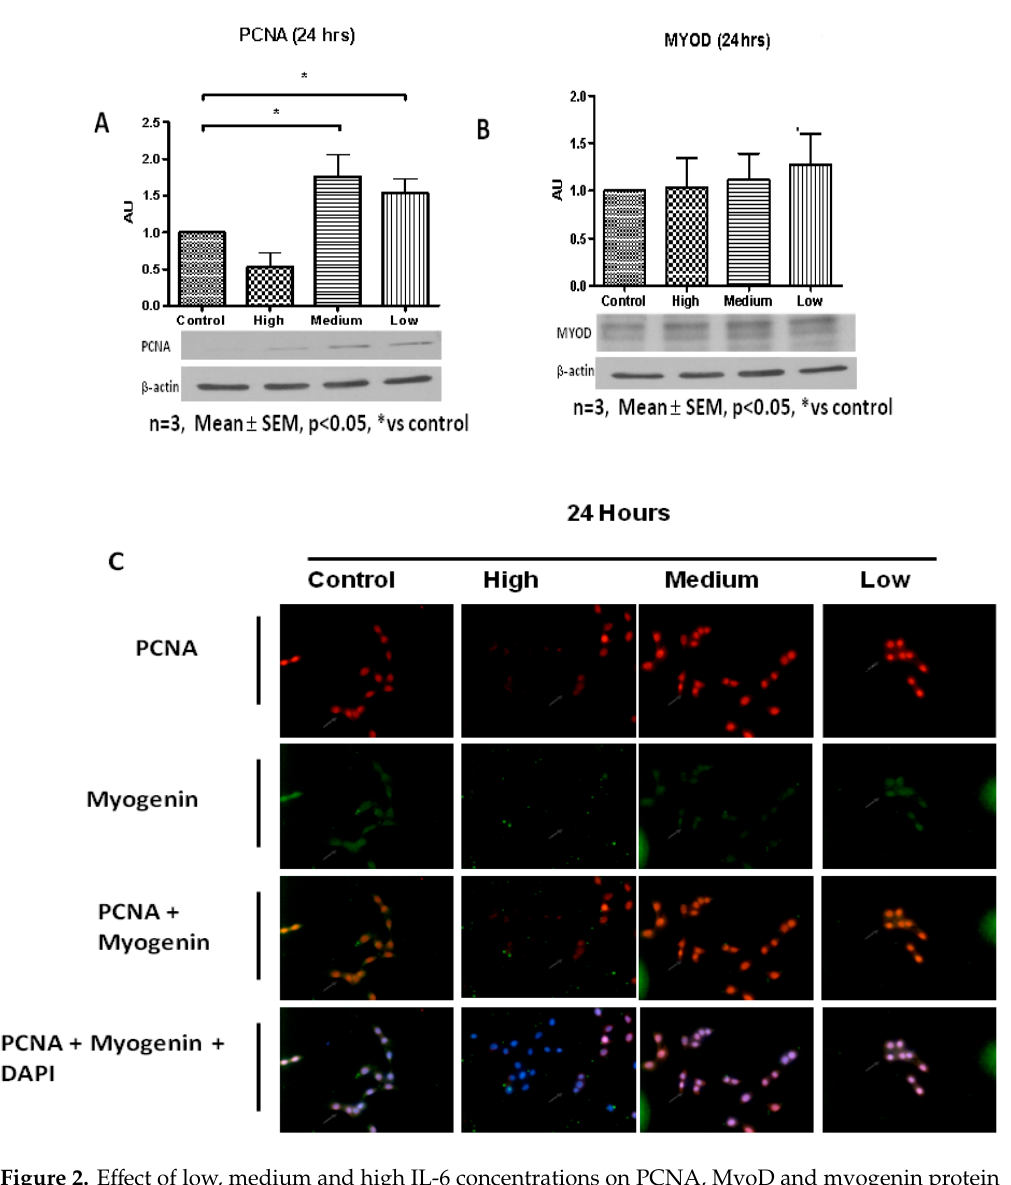
Figure 2. E ff ect of low, medium and high IL-6 concentrations on PCNA, MyoD and myogenin protein levels in C2C12 cells. ( A ) PCNA protein levels in C2C12 cells treated with low, medium and high IL-6 concentrations for 24 h. ( B ) MyoD protein levels in C2C12 cells treated with low, medium and high IL-6 concentrations for 24 h. ( C ) Immunofluorescence staining for PCNA and myogenin in C2C12 cells treated with low, medium and high IL6 concentrations for 24 h. The experiment was repeated three times. Immunofluorescence images were taken at 100 × magnification. Results are presented as mean ± standard error of the mean (S.E.M). Statistical analysis: ANOVA and Bonferroni post hoc test. * p < 0.05.